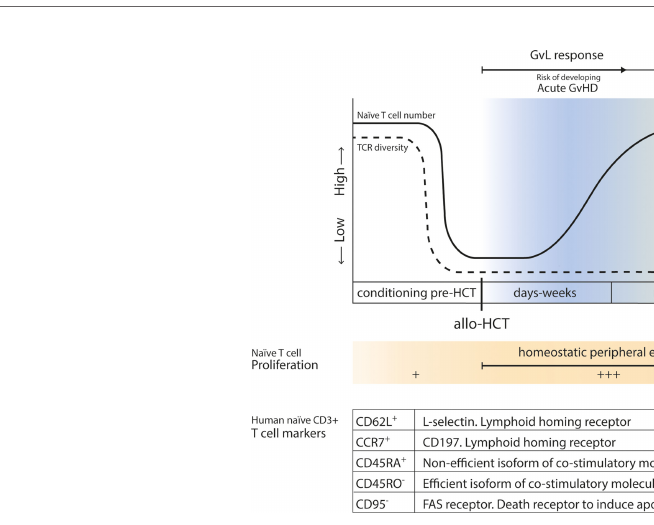
FIGURE 1 | Levels of naive T cells before and after allo-HCT. Before transplantation, levels of recipient naive T cells drastically drop due to conditioning regimens, radiation and serotherapy. In the fi rst few months after allo-HCT, after an ultimate low, lymphopenia induced HPE of donor-derived naive T cells will increase levels of naive T cells. After 6-12 months, thymopoiesis will start to be restored and production and release of RTEs leads to an increase in TCR diversity. Acute GvHD may develop early after allo-HCT, while chronic GvHD may occur later after transplantation. GvL responses contribute to the prevention of disease relapse later after allo- HCT. In the table markers associated with a naive CD3+ T cell phenotype are summarized, and their function is shortly